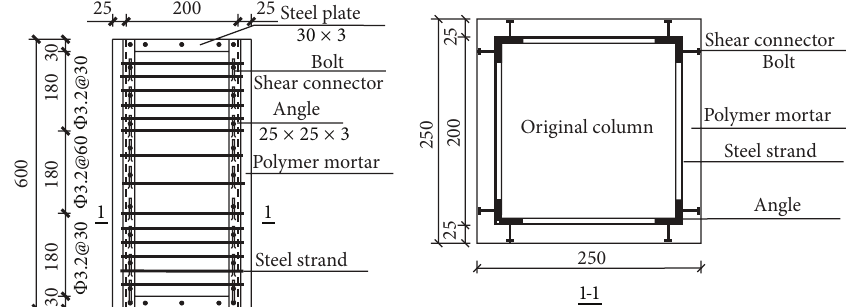
Figure 2: Strengthening design of the column (unit: mm).